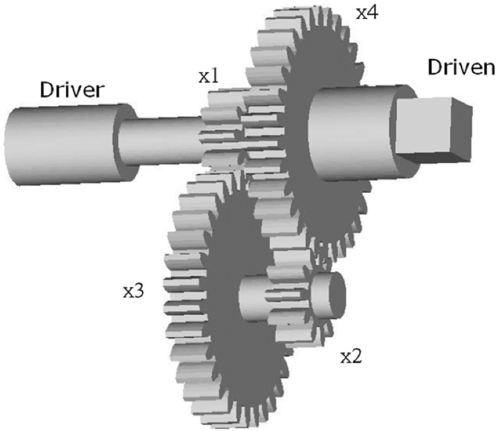
Figure 3. Gear train design problem.